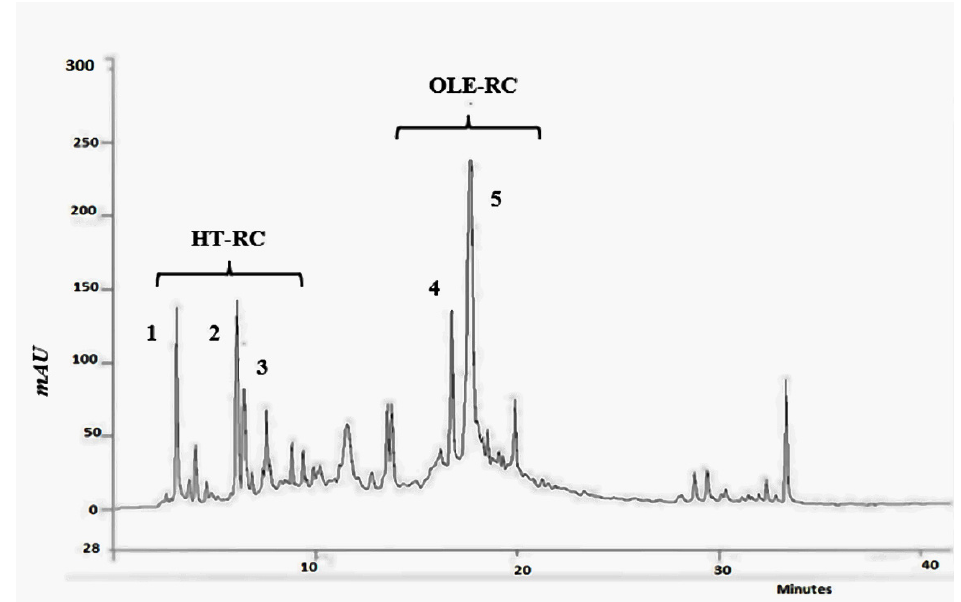
Figure 3. HPLC chromatogram (280 nm) of the frieze-dried two-phase olive pomace (FD-TPOP) extract showing the phenolic compounds selected and quantified in the two-phase olive pomace beverages. Peaks: (1) 3,4-dihydroxyphenylglycol; (2) hydroxytyrosol 4- β -D-glucoside; (3) hydroxytyrosol; (4) unknown; (5) unknown. HY-RC: hydroxytyrosol-related compounds; OLE-RC: oleuropein related compounds.